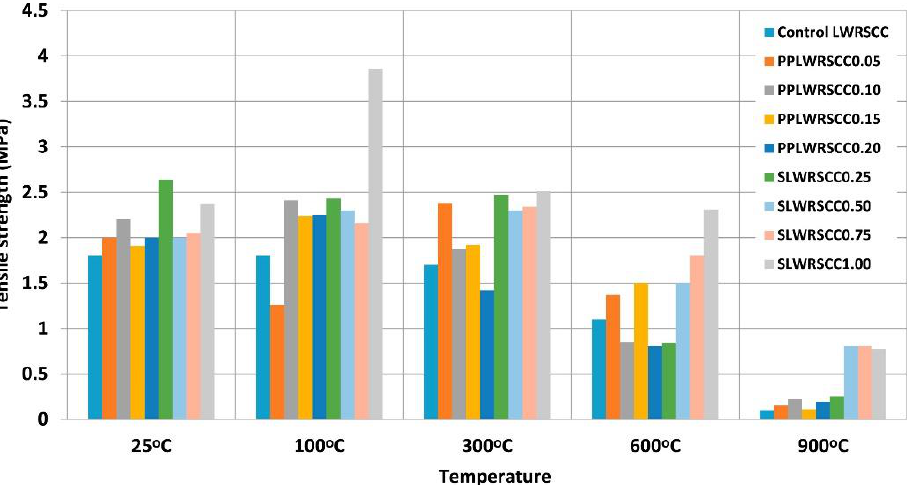
Figure 17. Impact of changing volume fractions of PP fiber and SF on the tensile loading capacity of FRAC. Copyright permission is obtained from [51].